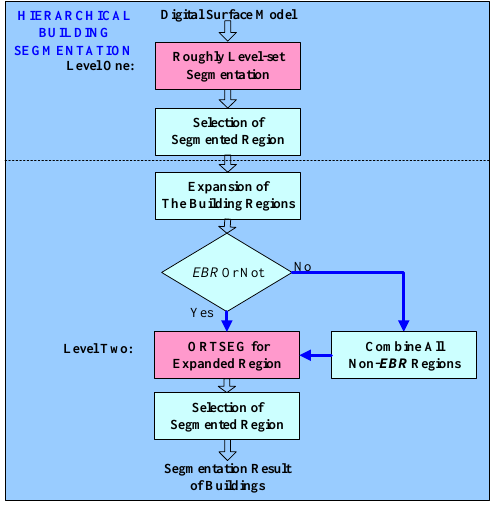
Figure 6. Hierarchical LS-ORTSEG building segmentation.